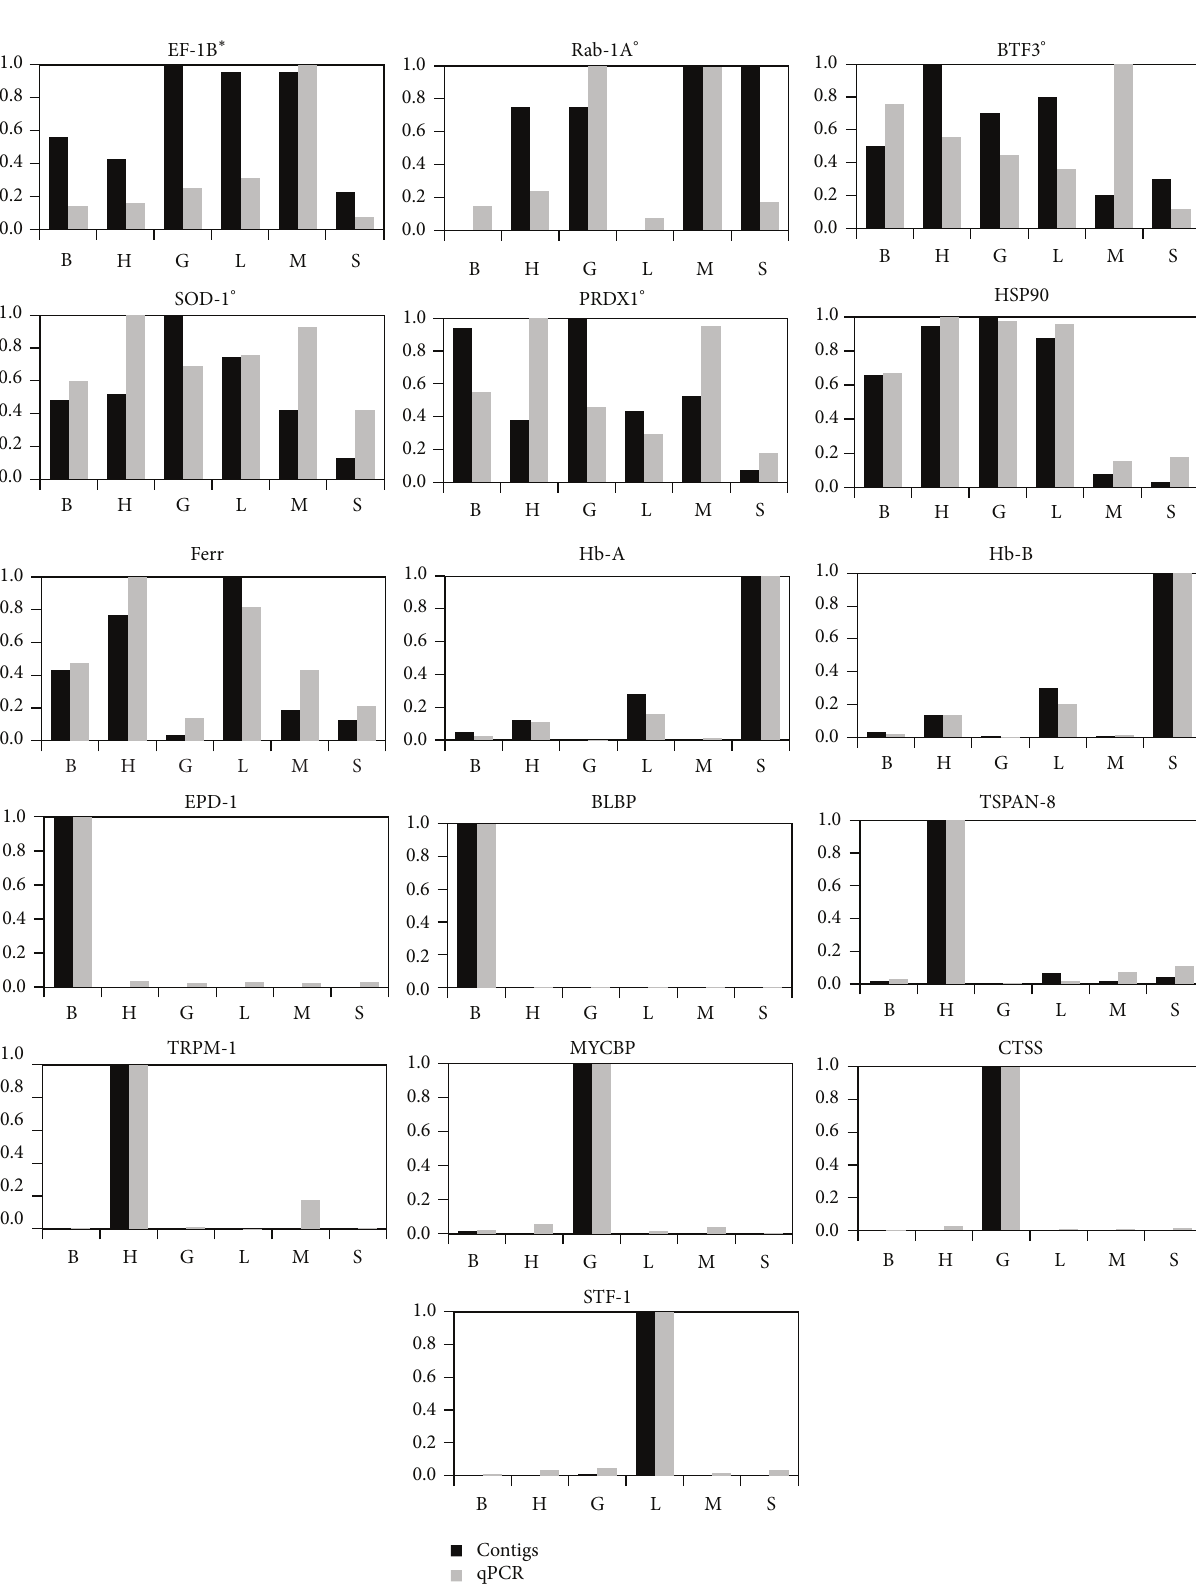
Figure 3: Comparative plots of relative expression as contig frequencies versus mean qPCR values for all genes selected for this study. Codes for each of the gene are listed in Table 1, S = spleen, B = brain, H = heart, G = gonad, L = liver, and M = muscle; the correlation coefficient (Pearson’s 𝑟 ) resulted to be highly significant ( 𝑃 < 0.0001 ) for most of the genes except for ∗ 𝑃 < 0.05 and ∘ not